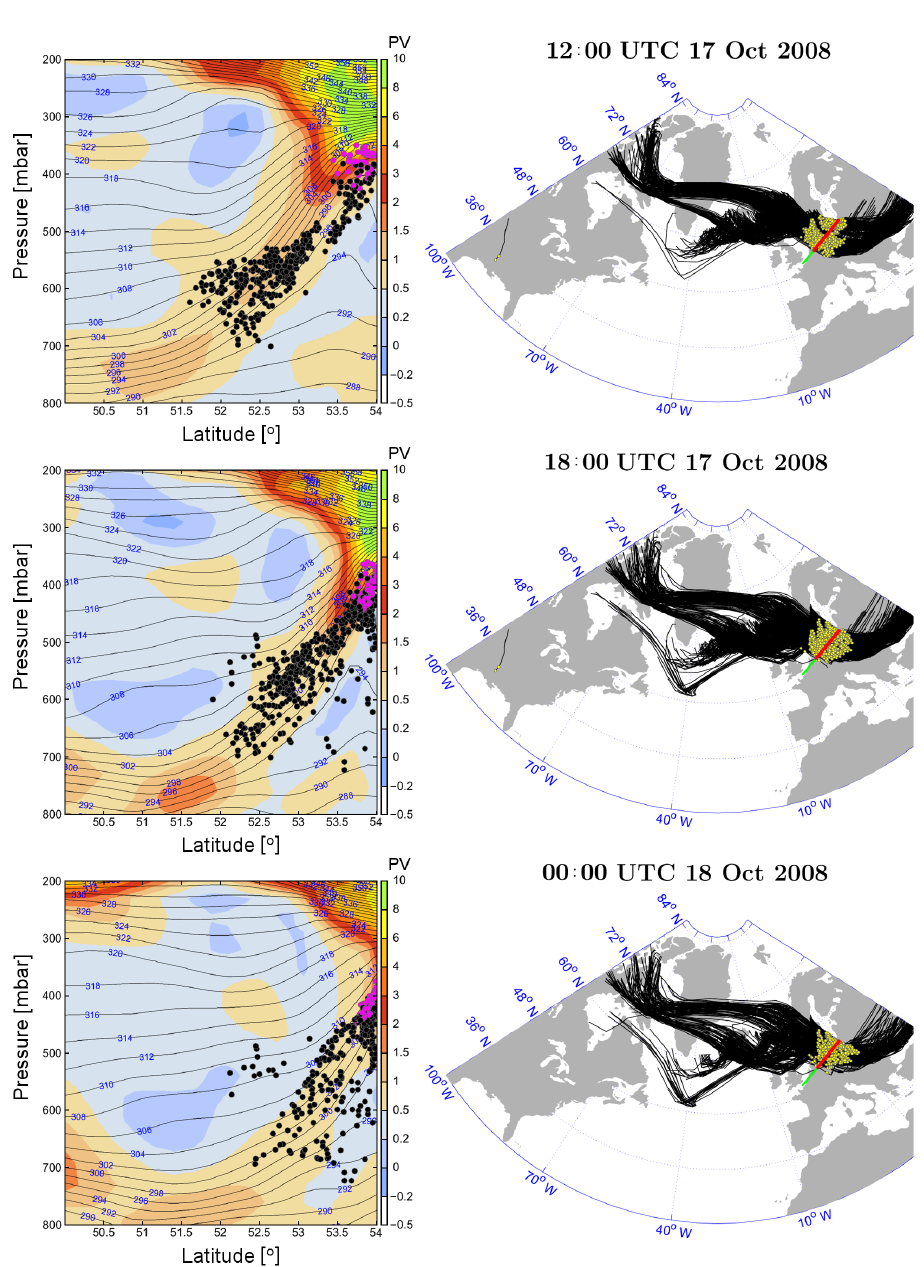
Figure 15. Right panels: intrusion trajectories (black lines) intersecting a vertical control surface (green line) along the coast of the Nether- lands, Germany, and Poland at three different times; left panels: intersection points of the trajectories on the control surface (see text); the blue contour lines are isentropes (in